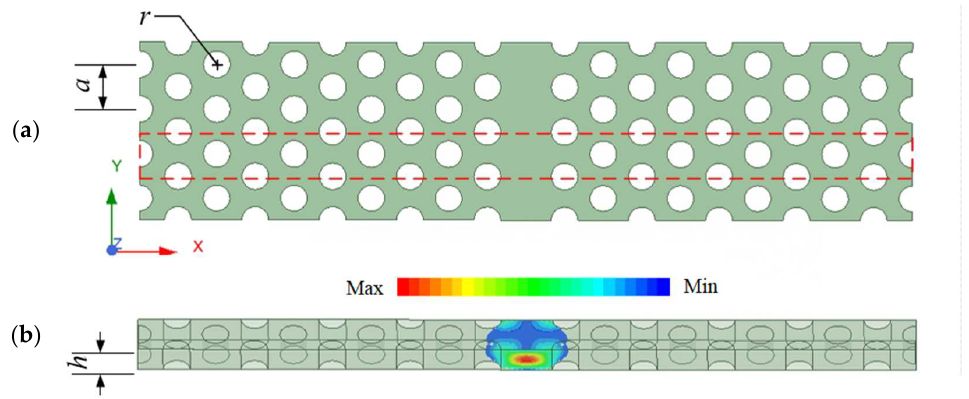
Figure 1. Structure of the PC slab wave-guide. ( a ) Top view of the designed PC slab wave-guide structure with dimensions (in the red dashed line is a supper-cell). ( b ) The super-cell of the PC wave-guide with the field distribution of the wave-guide mode.